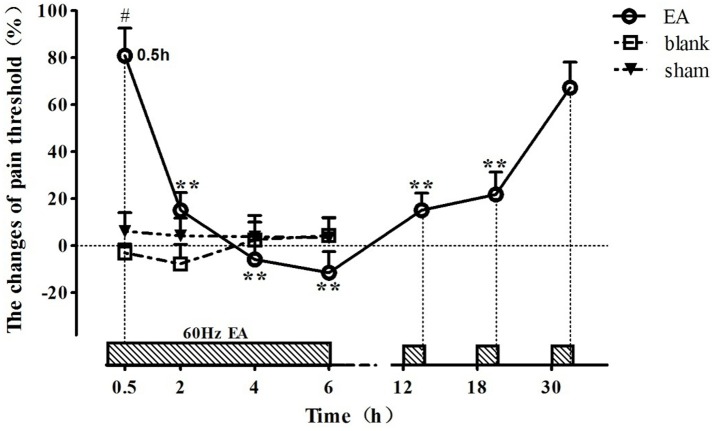
The time course of EA tolerance in goats (mean ± SD, %, n = 6). Goats were stimulated with 60 Hz EA. ∗∗Indicates the change of pain threshold is different (p < 0.01) from that at 0.5 h. #Indicates there was difference (p < 0.01) in the change of pain threshold between the EA-treated goats and the blank or sham control-treated goats. Repeated ANOVA followed by Bonferroni’s post-test.